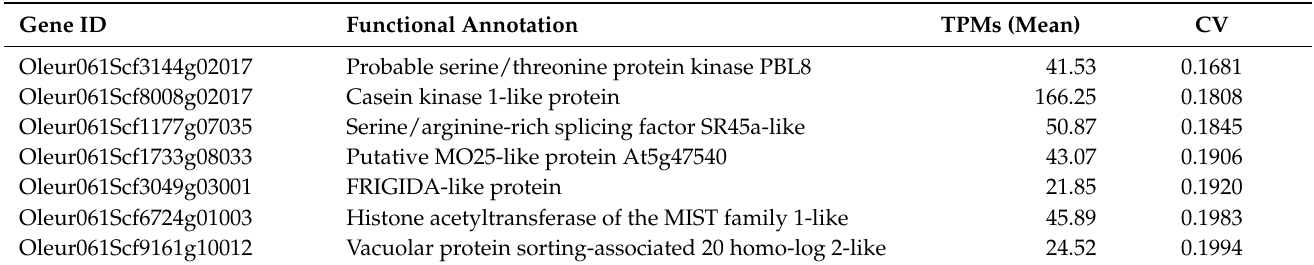
Table 3. Expression and coefficient of variation of least variable